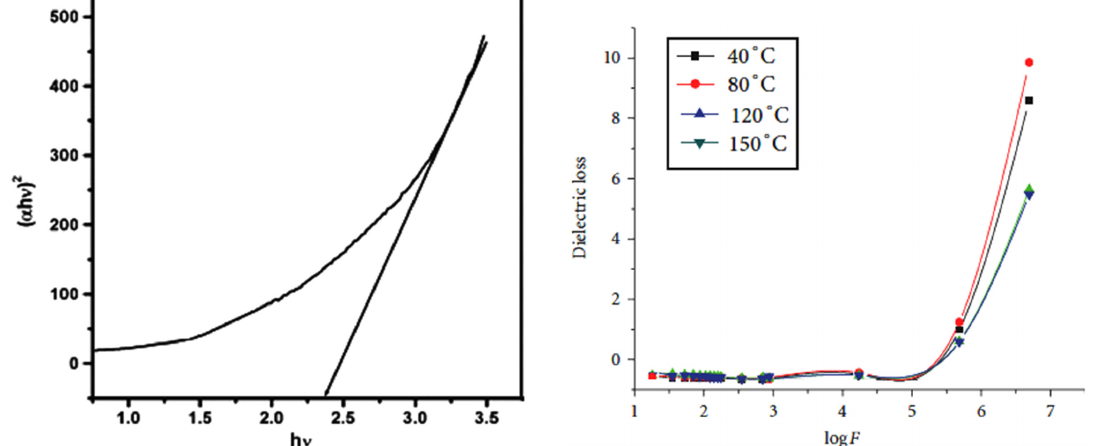
Figure 7. Dielectric loss of CuSe thin